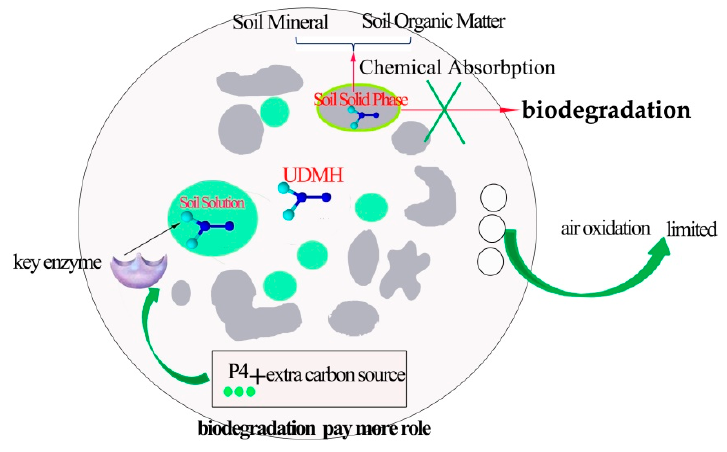
Figure 10. The influence of extra carbon source on UDMH degradation for P4 strain in soil.